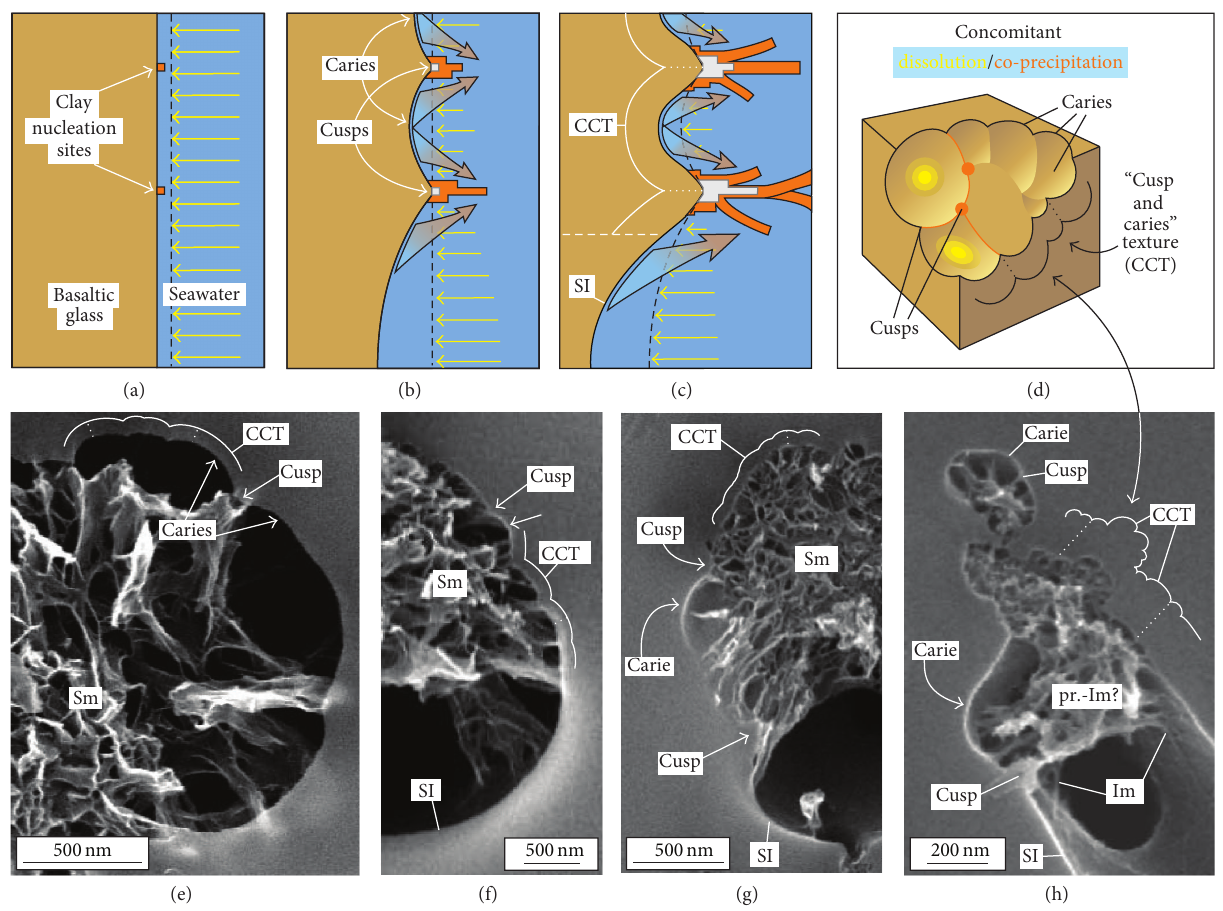
Figure 14: SEM images and a schematic model (a–d) explaining the origin of “cusp and caries” texture observed along the walls of fission track etch-tunnels (FTETs) and alpha-recoil track etch-tunnels (ARTETs) in basaltic glass. The secondary electron images in (e–h) are all close-up SEM images from other figures: (e) and (f) are close-up images from Figure 13(b); (g) is a close-up from Figure 13(d); and (h) is a close-up from Figure 12(e). Schematic model (a–d): at locations distal to the nucleation sites of secondary clays, the glass-water interface (i.e., dissolution front) is quite smooth and featureless (see “SI” in (c) and (f–h) and also in Figures 13(a)–13(d)). In contrast, where glass dissolution (yellow) is accompanied by the nearby nucleation and growth of secondary clays (orange), the protective effect of the newly formed clay minerals ( ± the kinetics of the dissolution/co-precipitation process—see orange/blue and yellow arrows in (b) and (c)) results in the formation of “cusps” along the dissolution front that are separated by “caries” (b)—the latter of which form by dissolution of glass as a concave front/incursion (slightly distal to secondary clay formation). In the case of FTETs, the secondary clay that forms during development of cusp and caries texture is platy smectite (e–g), whereas for ARTETs the secondary mineral is filamentous imogolite ((h); Figures 12(e), 12(g), and 12(h)). CCT: “cusp and caries” texture; Im: imogolite; pr.-Im?: proto-imogolite?; SI: smooth interface; Sm: platy